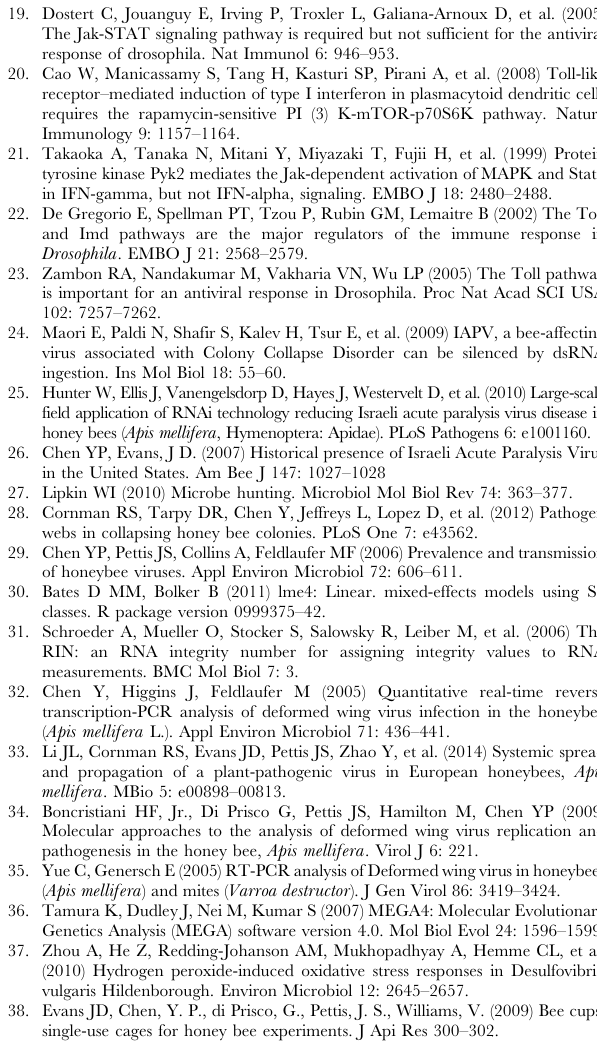
Figure S2 Amplification efficiencies of IAPV and b -actin. The difference between the Ct value of IAPV and Ct value of b - actin ( D Ct) was plotted versus the log of six 10-fold dilutions of total RNA. The plot of log total RNA input versus D Ct has a slope less than 0.1, indicating that the efficiencies of the two amplicons were approximately equal. Therefore, the DD Ct calculation for the relative quantitation of IAPV in this study was valid. (TIF) Figure S3 Microarray data validation. A) Principal com- ponent analysis (PCA) scatter plot. PCA analysis of all differentially regulated genes clearly separates the two different data sets IAPV positive (IAPV + ) and IAPA negative (IAPV 2 ) for both adults and brood (4 th and 5 th instar larvae, prepupae and white-eyed pupae). B) Unsupervised hierarchical clustering of gene expression data. Hierarchical cluster analysis shows the differential expression of genes in both adults and brood in response to IAPV infection. C) Variance ratios from ANOVA (error set to 1). For both adults and brood, variance of treatment (IAPV infected VS. uninfected) was significantly higher than error ( r , 0.01). D) Volcano Plot. The volcano plots show a large group of up and down regulated genes in response to IAPV infection in adults and brood. Each dot